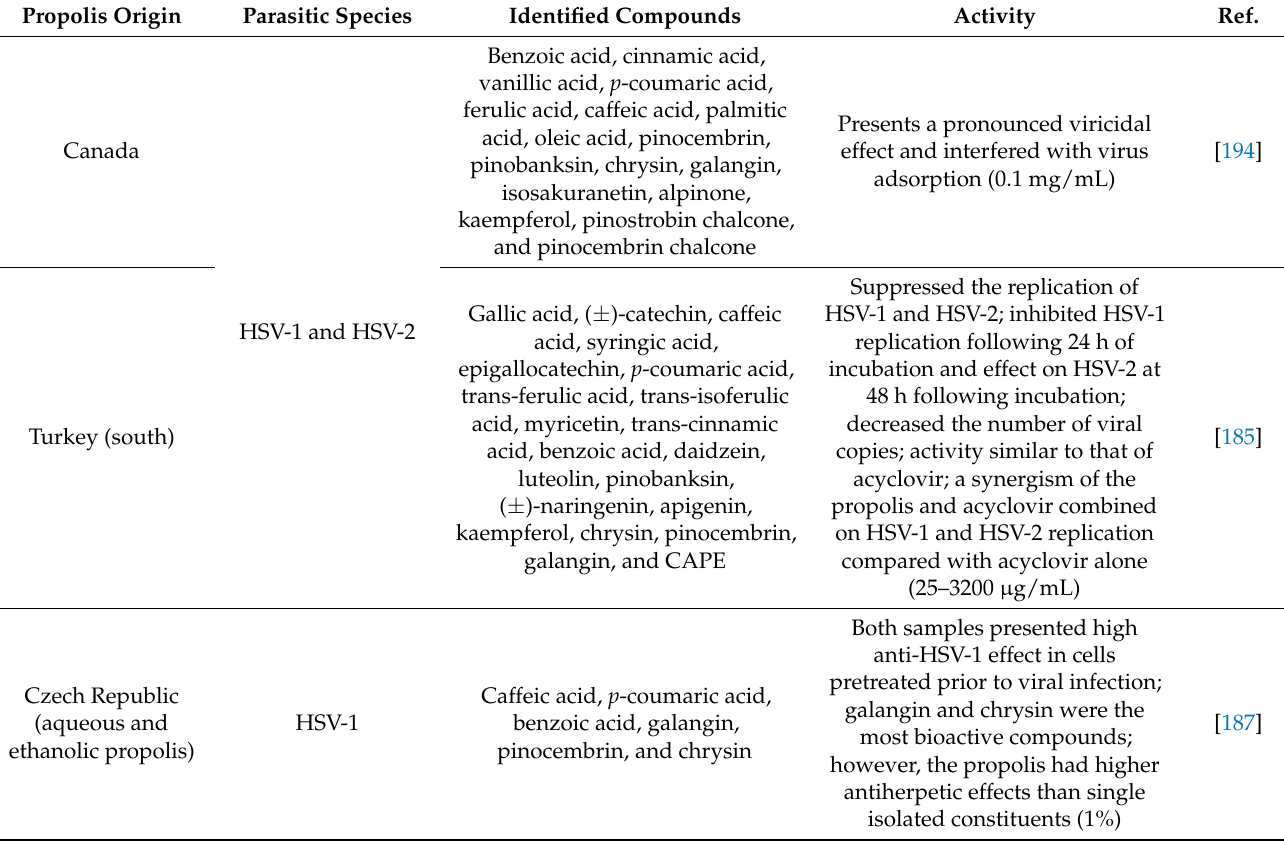
Table 18. Anti-HSV-1 and HSV-2 activity of several propolis and its chemical